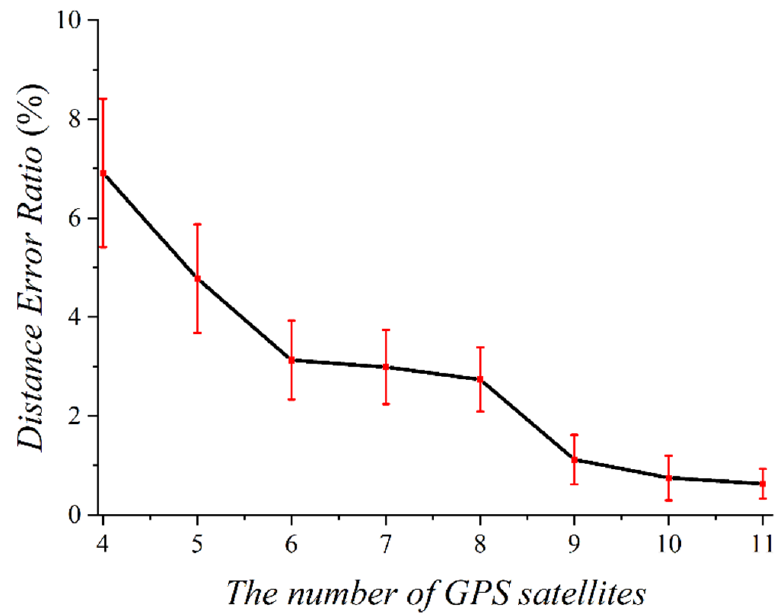
Figure 1. Distance error ratio according to the number of receivable GPS satellites.